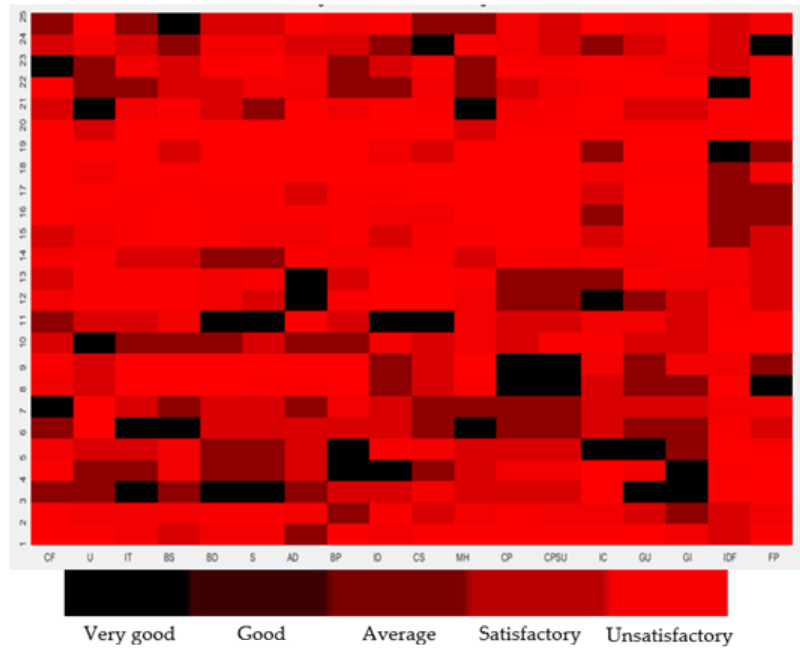
Figure 1. Map of the global quality indices in the analyzed commodity.